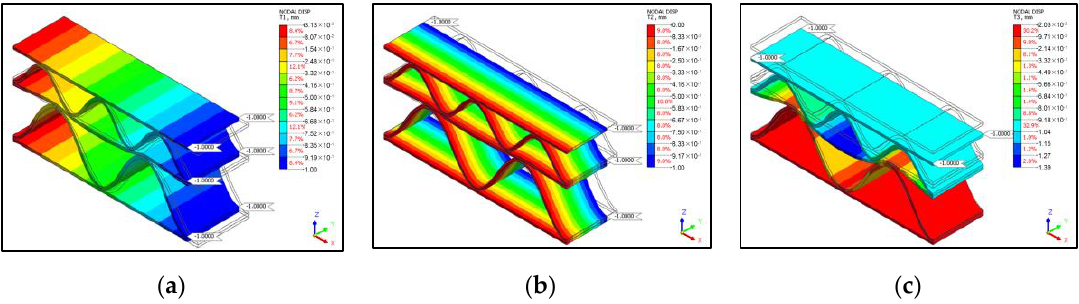
Figure 11. Directional reaction force for the unit cell of AB / F-DW corrugated paperboard, they should be list as: ( a ) x -direction; ( b ) y -direction; ( c ) z -direction.